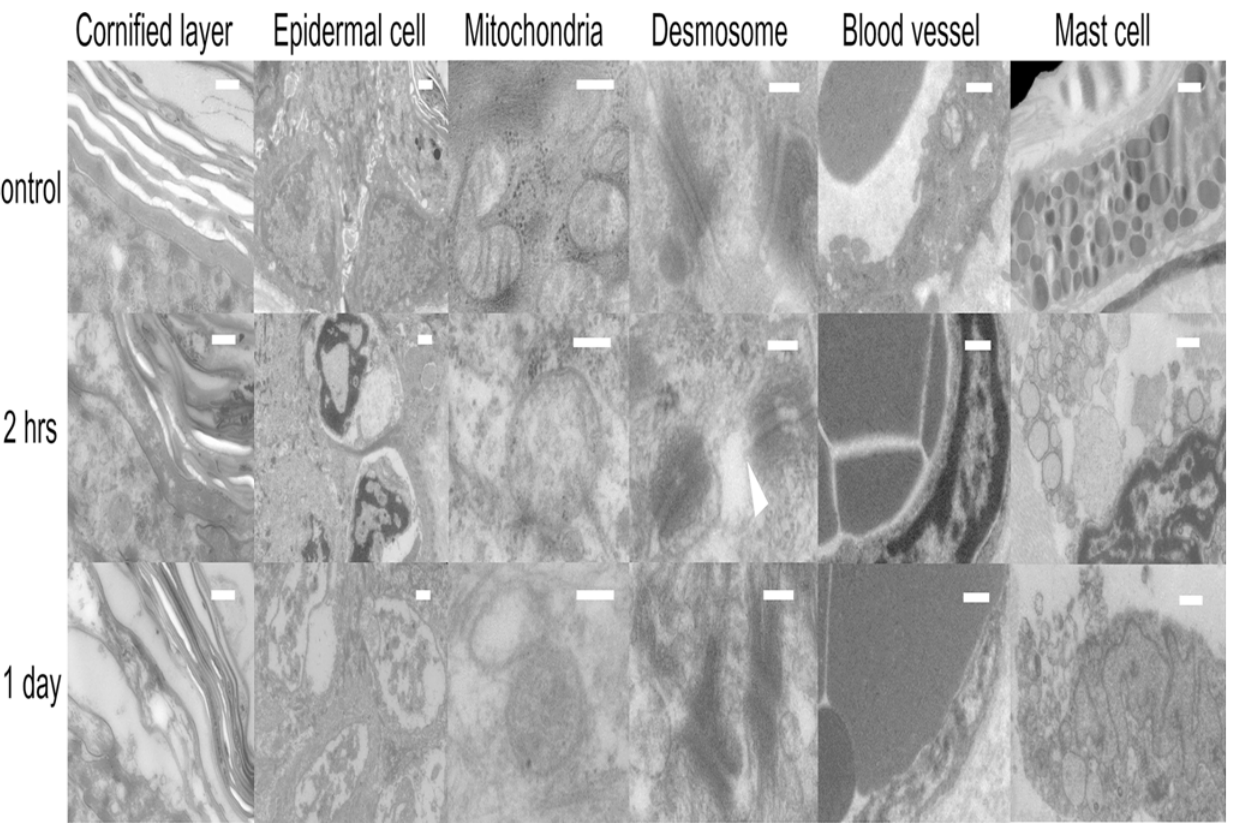
Fig 2. Transmission Electron Microscope (TEM) image of skin constituents. The length of scale bars is 0.5 μ m in cornifyed layer, 1 μ m in epidermal cells, 0.2 μ m in mitochondria, 0.2 μ m in desmosomes, 1 μ m in blood vessels and 1 μ m in mast cells. All constituents were observed at 2 hrs and 1 day after cyoablation. Discontinous cell menbrane ( ▲ , arrowhead) was observed in the vicinity of desmosome, suggesting dysruption of cell menbrane by cryoablation.